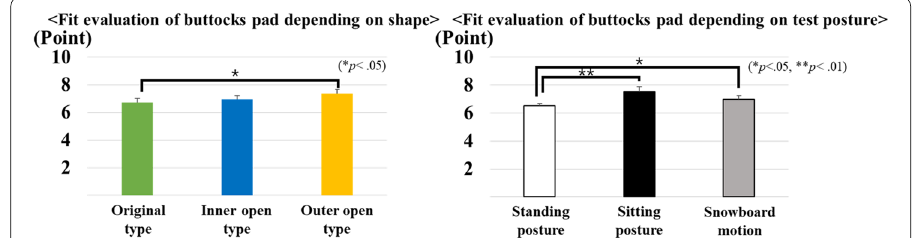
Table 6 Subjective motion comfort depending on material and shape (repeated measures ANOVA) Type III sum of squares df p -value